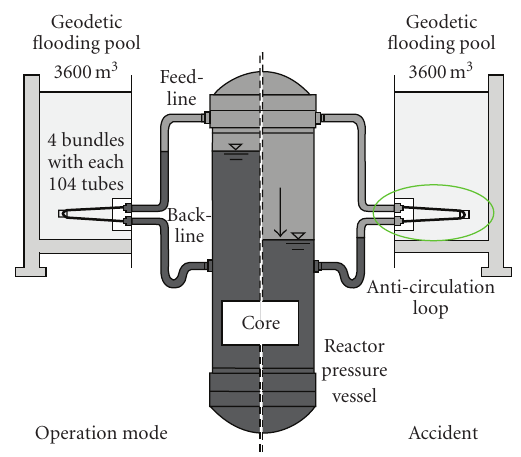
Figure 1: Emergency condenser of the SWR1000.